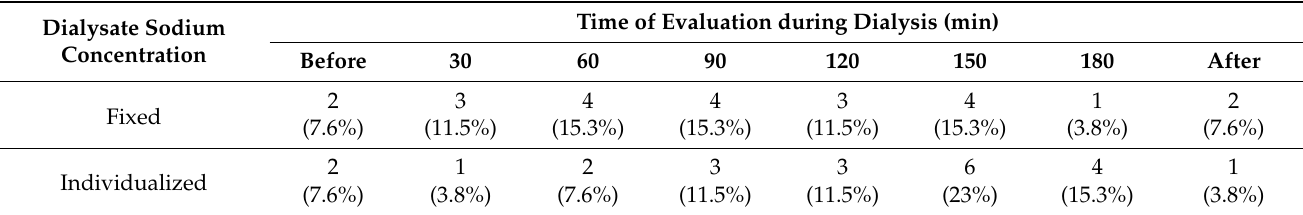
Table 3. Events of IOP ≥ 22 mmHg in 26 pairs of eyes (13